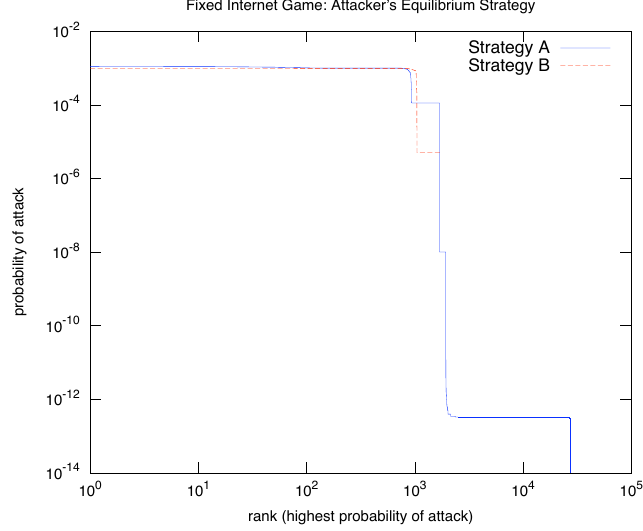
Figure 4. Attacker’s Equilibrium Strategy on an Internet Game Instance (Fixed). The graph shows the > 0 for each node i , sorted in decreasing order (in log-log scale), for attacker’s Strategy A values of y ∗ i (blue/denser-dots line) and Strategy B (red/sparser-dots line) at an MSNE of the single instance of the Internet